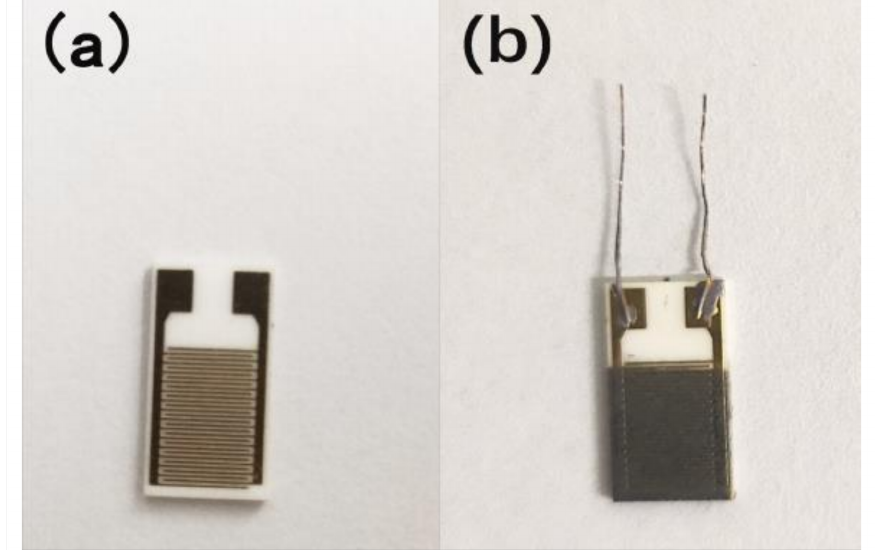
Figure 1. ( a ) Photo images of the Al 2 O 3 substrate with Au interdigitated electrodes; and ( b ) the MAPbI 3 -based humidity sensor.